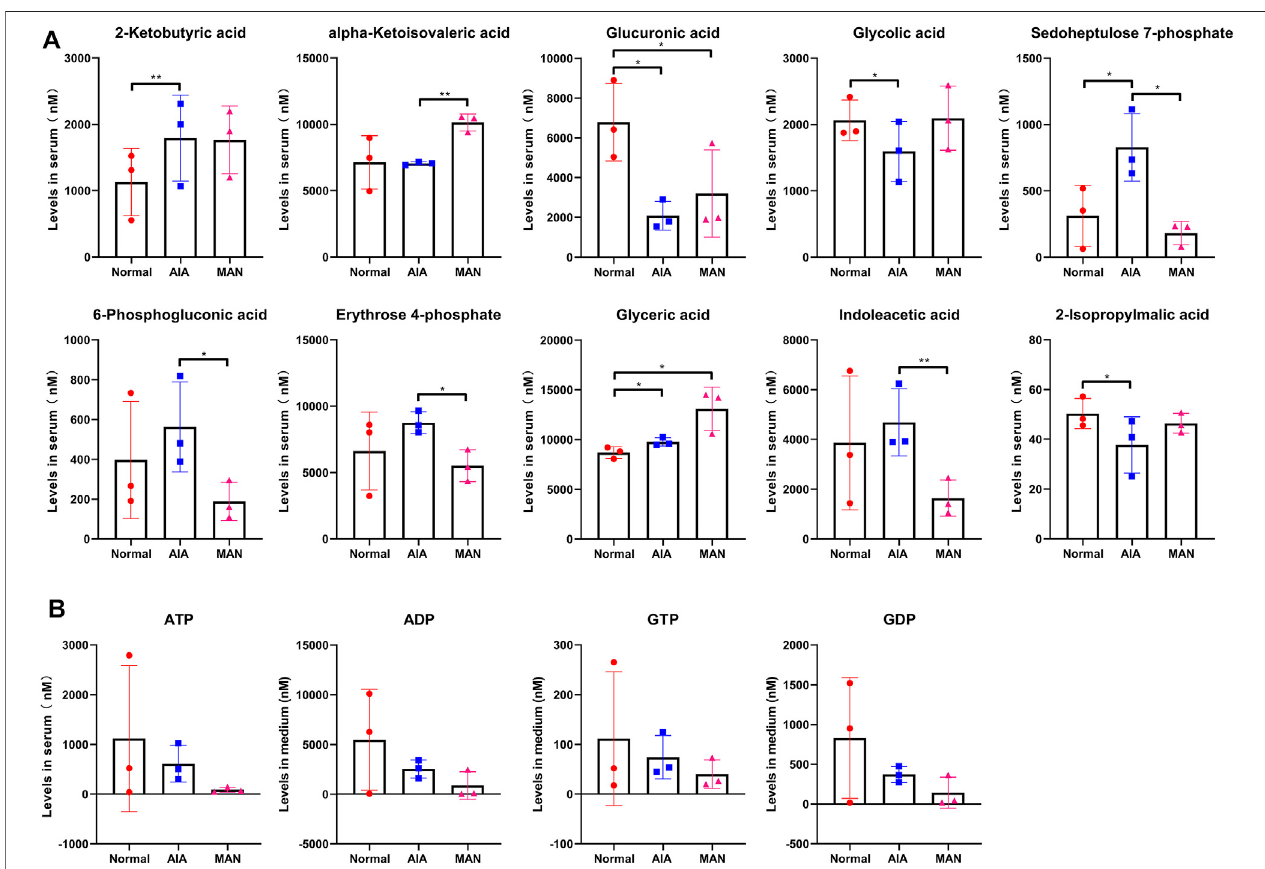
FIGURE 6 | Supporting evidences for the regulation of MAN on glucose metabolism in AIA rats. (A) , levels of glycometabolism metabolites indirectly related to glycolysis and aerobic oxidation of glucose detected in rat plasma ( n (cid:2) 3); (B) , levels of high-energy phosphate compound in rat plasma ( n (cid:2) 3).